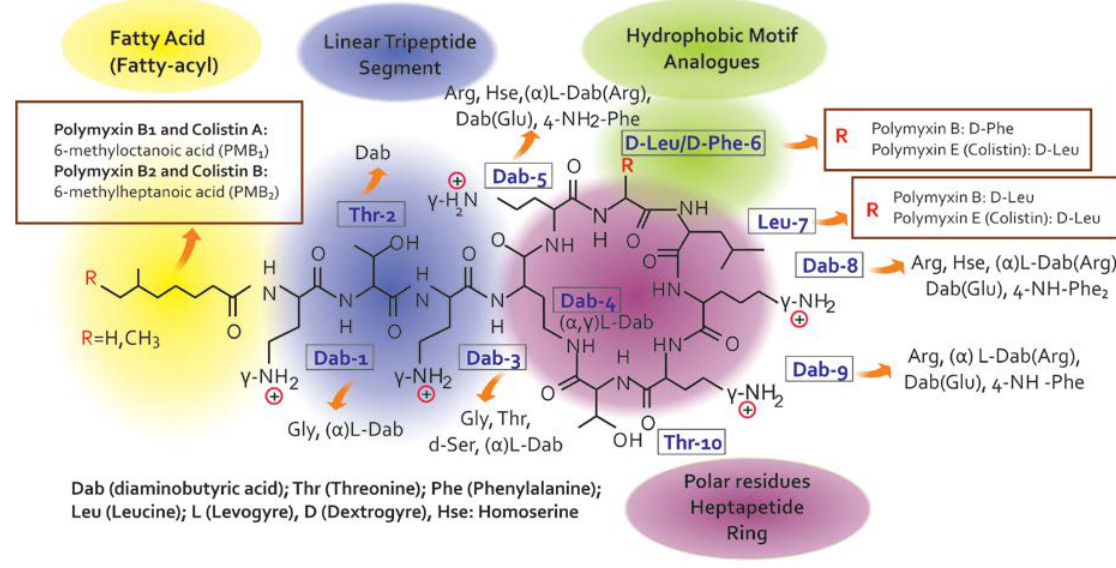
Figure 2. Chemical structure of colistin and polymyxin B [22] .